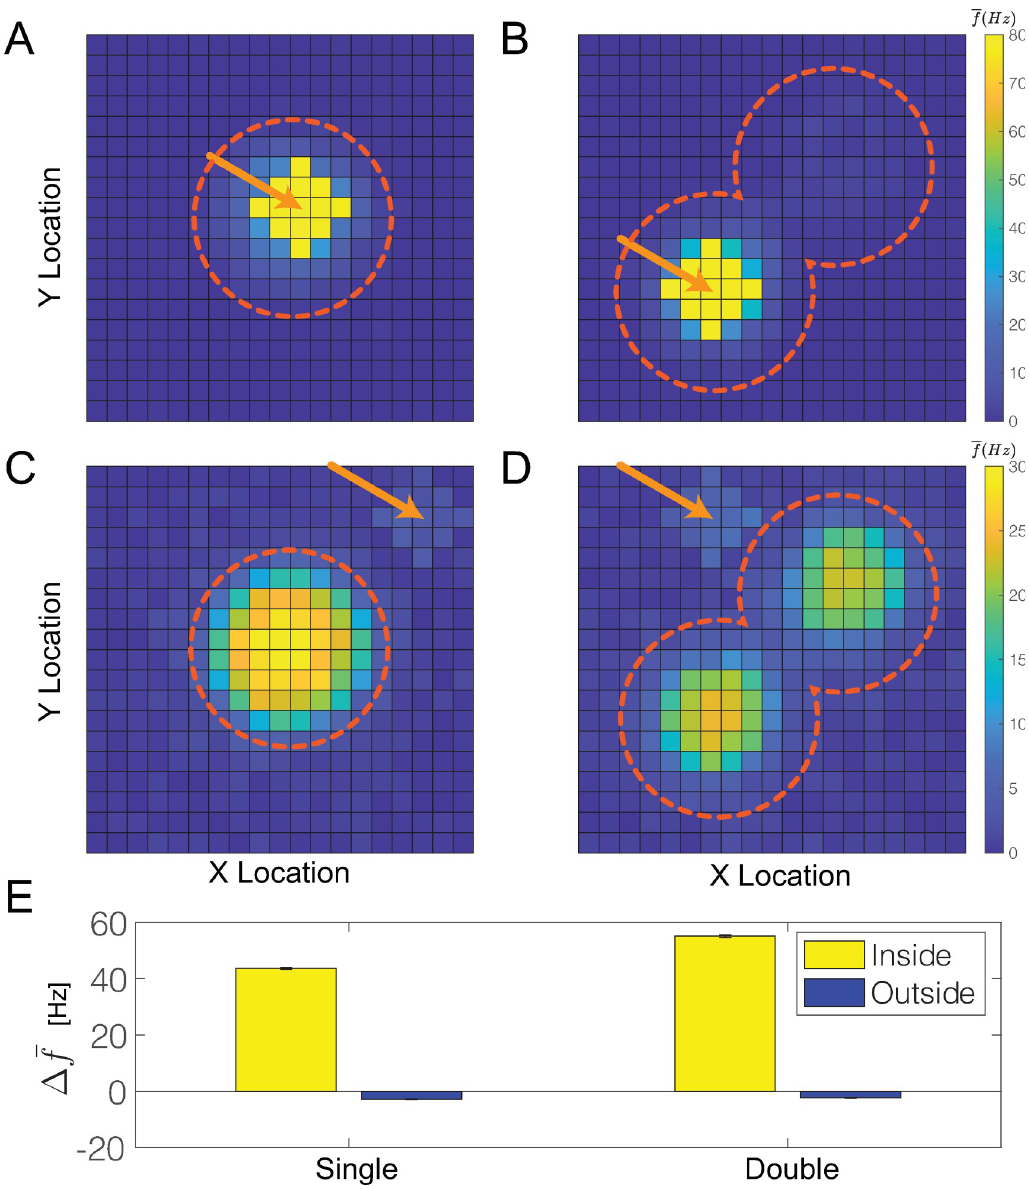
Fig 7. Firing response to an external stimulus with single and double peak g cell firing frequencies plotted as cell position on the E cell lattice showing varied firing responses to an external excitatory stimulus targeting a subset of E cells. Dashed circles indicate location and radius of g targeted cells. Targeted cells were either inside (A, B) or outside (C, D) of the g responses of the targeted E cells to the external stimulus relative to their responses in the absence of g Ks modulation (homogeneous g at default value). Yellow (blue) bars correspond to when targeted E cells are inside (outside) the g Ks The four bars from left to right correspond to cases shown in A, C, B and D,